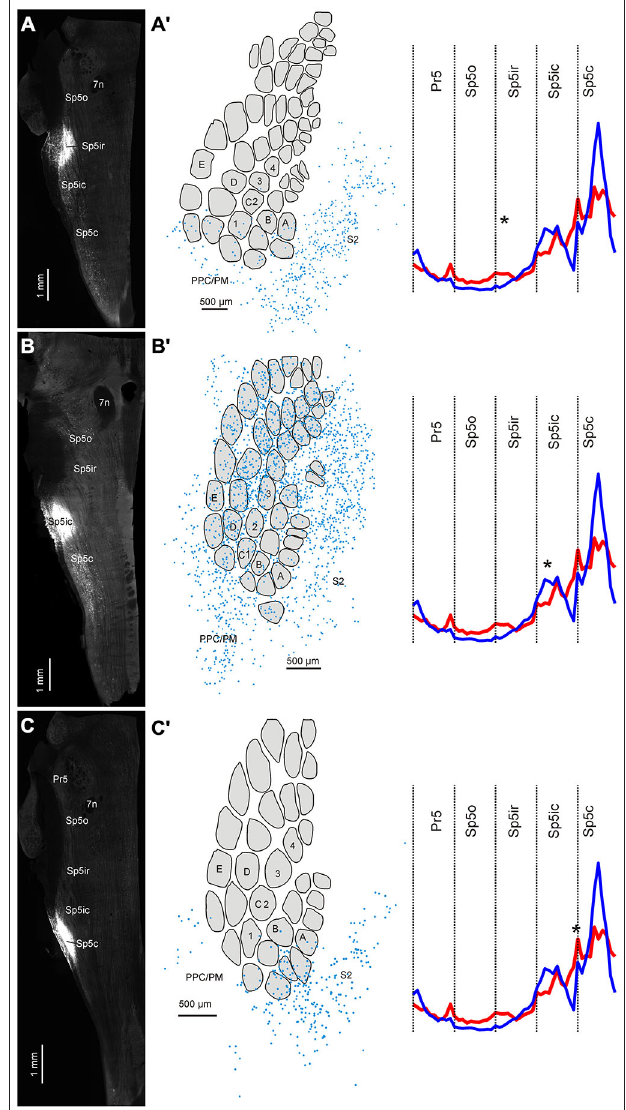
FIGURE 7 | Three cases showing the distribution of retrogradely labeled cells in cortex following FG deposits at different rostrocaudal positions in the trigeminal sensory nuclei. (A) FG deposit into the Sp5ir. (A (cid:48) ) Digital reconstruction of retrogradely labeled cells in cortex superimposed on an outline of layer IV barrels and septa. Schematic shows the average distribution of binned terminals across the different trigeminal sensory nuclei (taken from Figure 5 ) with the location of the current injection marked with an asterisk. (B–C (cid:48) ) Identical plots for two other cases receiving tracer deposits into the Sp5ic and the Sp5ic/Sp5c